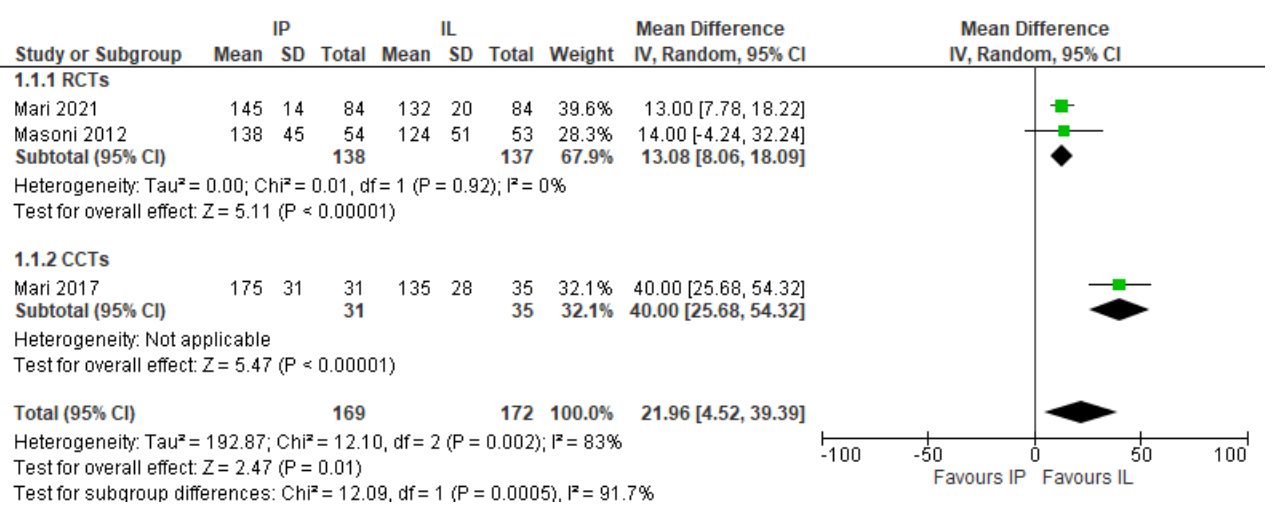
Figure 8. Operative time, risk ratio.